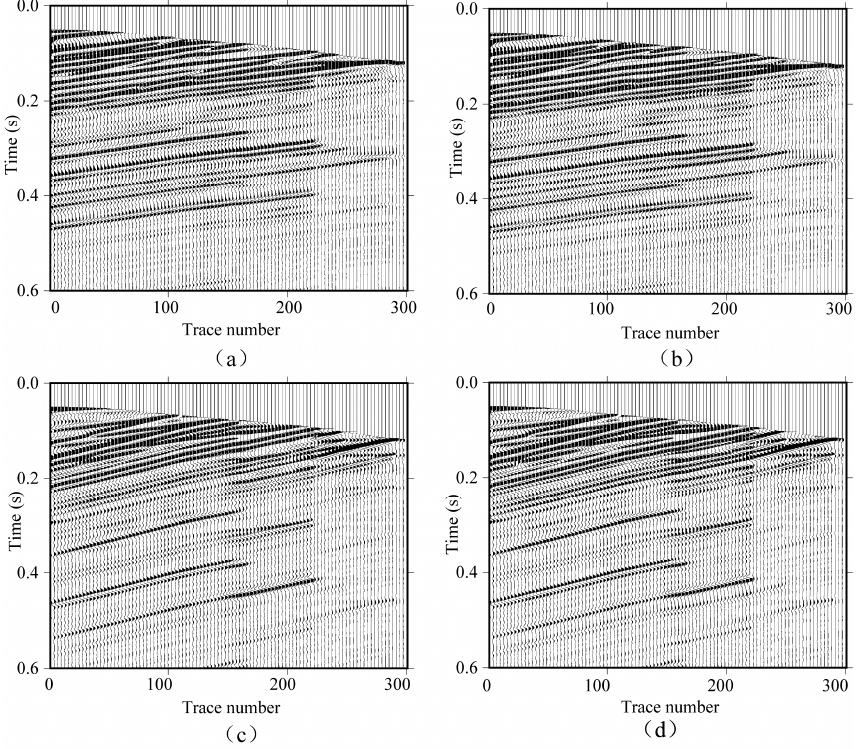
Figure 4. ( a , b ) The upgoing waves separated from the corresponding vertical component of the time-lapse cross-well shot gathers with the shallow source position (400 m) from the baseline survey and first-repeat survey, respectively. ( c , d ) as in ( a , b ) but displaying the horizontal components instead. Next, we utilized CWI to estimate the velocity changes due to the CO 2 injection by cross-correlating the signals from the baseline and first-repeat cross-well seismic datasets over a moving time window for each receiver position. The size of the time window chosen depends on the wavelet frequency [44]. In order to avoid some fluctuations and outliers, the length of the time window should be at least four times the wave period [41]. The temporal velocity change was calculated at the center of the moving time window. Then, the mean velocity change was obtained by averaging the calculated temporal velocity changes over the entire seismic trace. Here, the moving time window length was equivalent to six periods at the center frequency. To avoid the cycle-skipping problem, Robinson et al. [30] restricted the time window range to find the maximum correlation coefficient. We also utilized the same method. The workflow chart including the utilized steps for CWI is shown in Figure